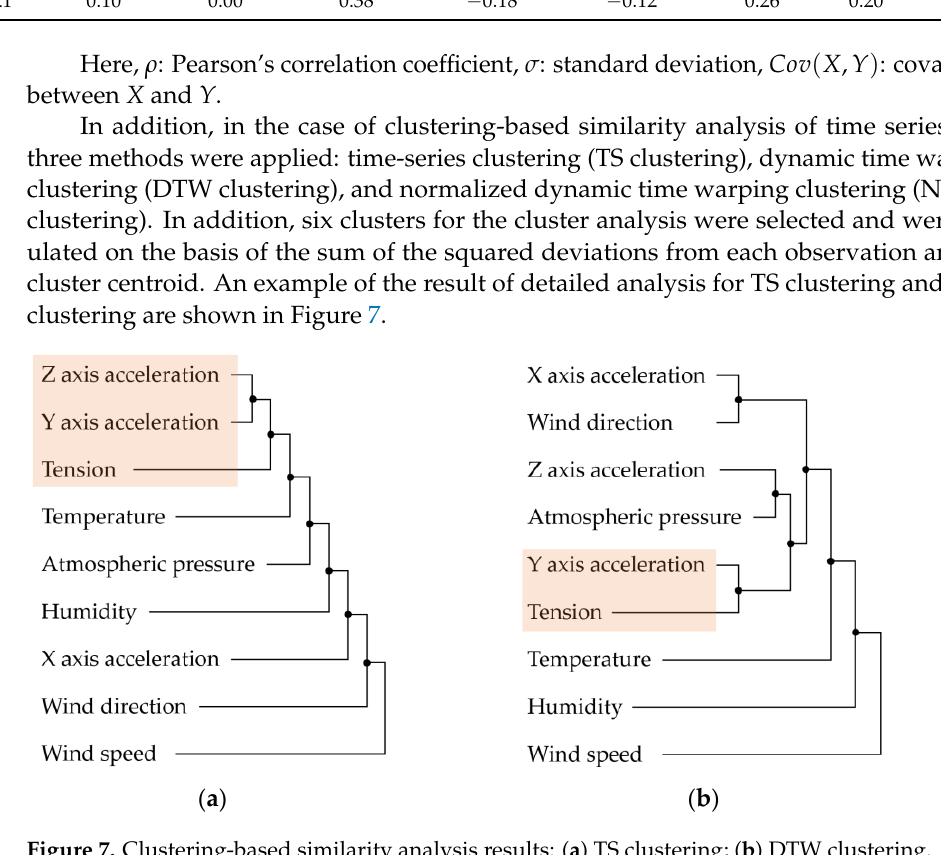
Figure 7. Clustering-based similarity analysis results: ( a ) TS clustering; ( b ) DTW clustering